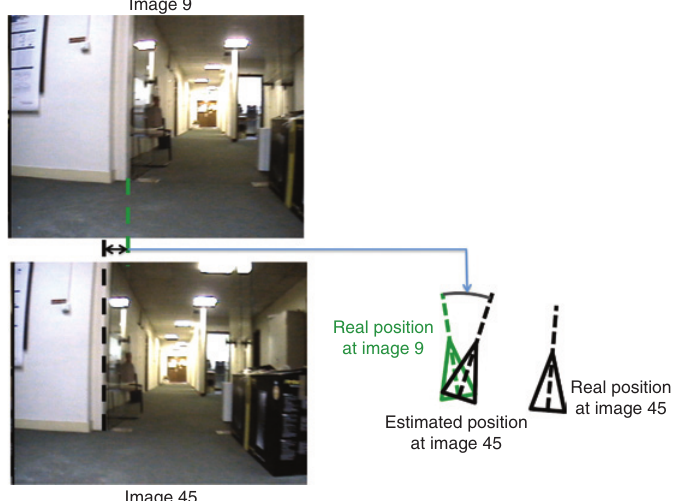
Figure 7. Illustration of the Qualitative Visual Localization. Left: A loop-closure is detected between two images with 33 pixels of x -axis translation. Given a camera field of view of 45 ° and 320 × 240 images, the computed robot rotation is 4.727 ° . Right: Estimated qualitative robot position and true positions.